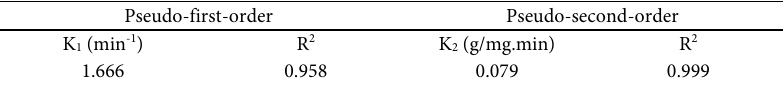
Fig. 10. Effect of pH on the removal efficiency of Pb(II) by nanoparticles. Table 4. Kinetic adsorption